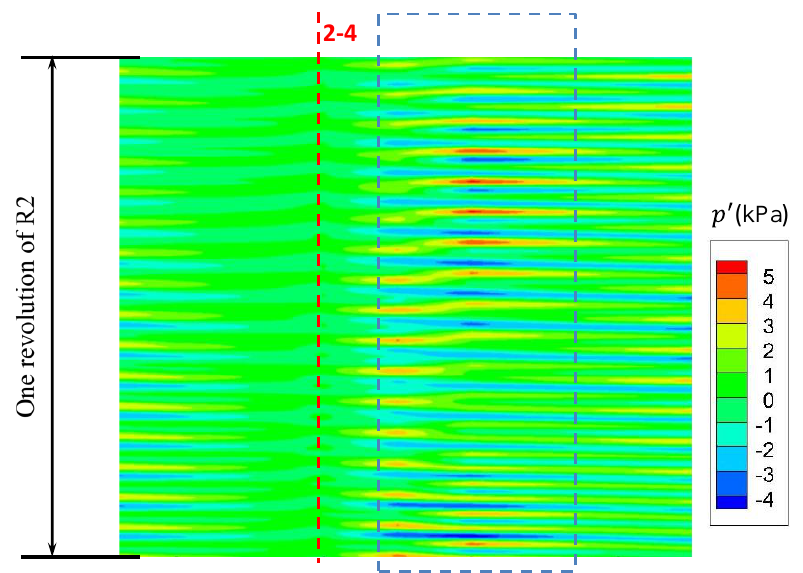
Figure 10 . The distribution of the combination of R1-1BPF and R1-2BPF inside R2 . Figure 10. The distribution of the combination of R1-1BPF and R1-2BPF inside R2.